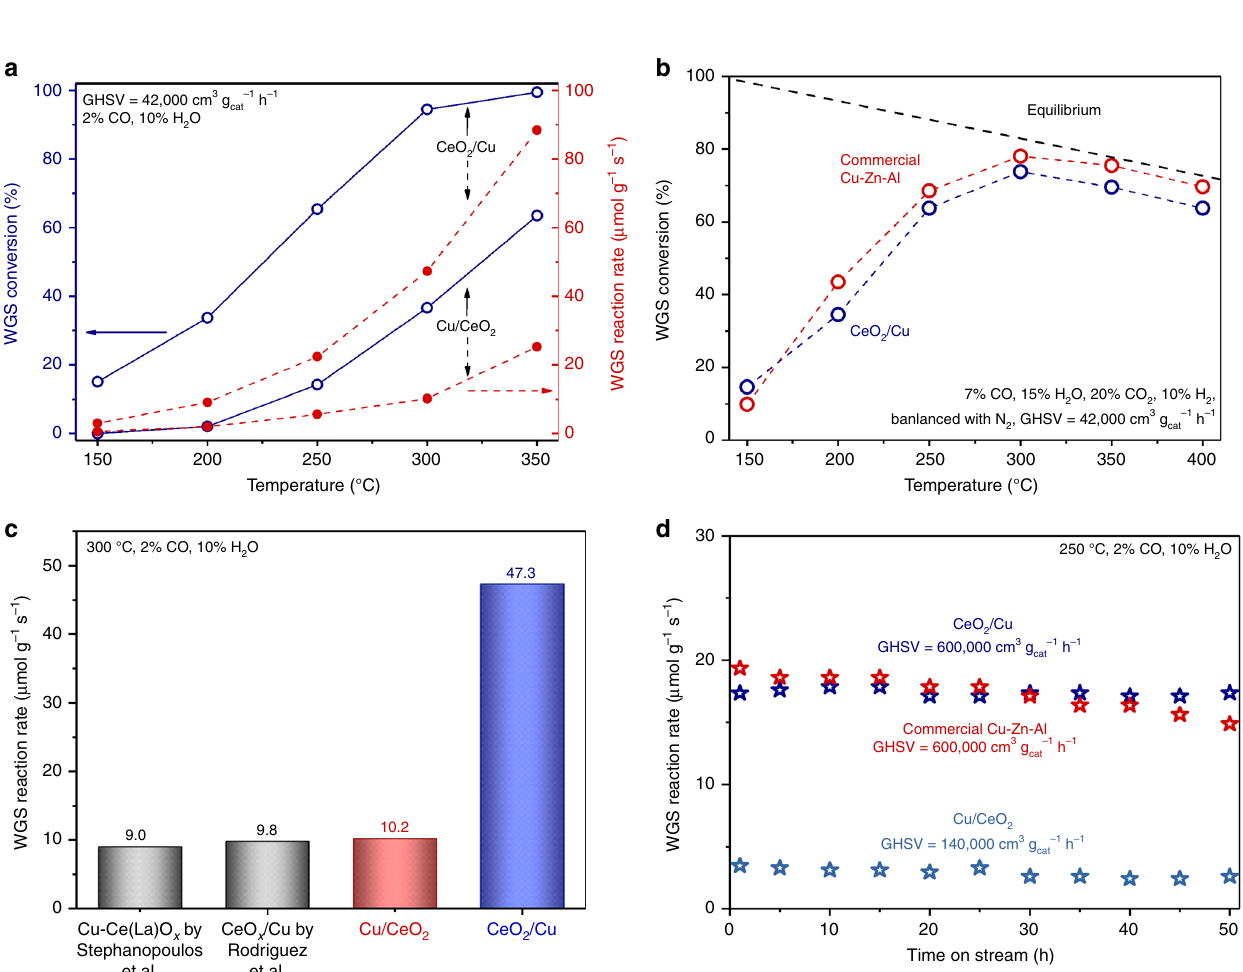
Fig. 1 Catalytic performances of the inverse CeO 2 /Cu catalyst. a Water – gas shift (WGS) activities of the inverse CeO 2 /Cu and normal Cu/CeO 2 catalysts. b WGS activities of the inverse CeO 2 /Cu catalyst and commercial Cu – Zn – Al under industrial atmosphere. c Comparison of WGS reaction rates for different catalysts at 300 °C. d Time-on-stream tests of the inverse CeO 2 /Cu, normal Cu/CeO 2 catalysts, and commercial Cu – Zn – Al